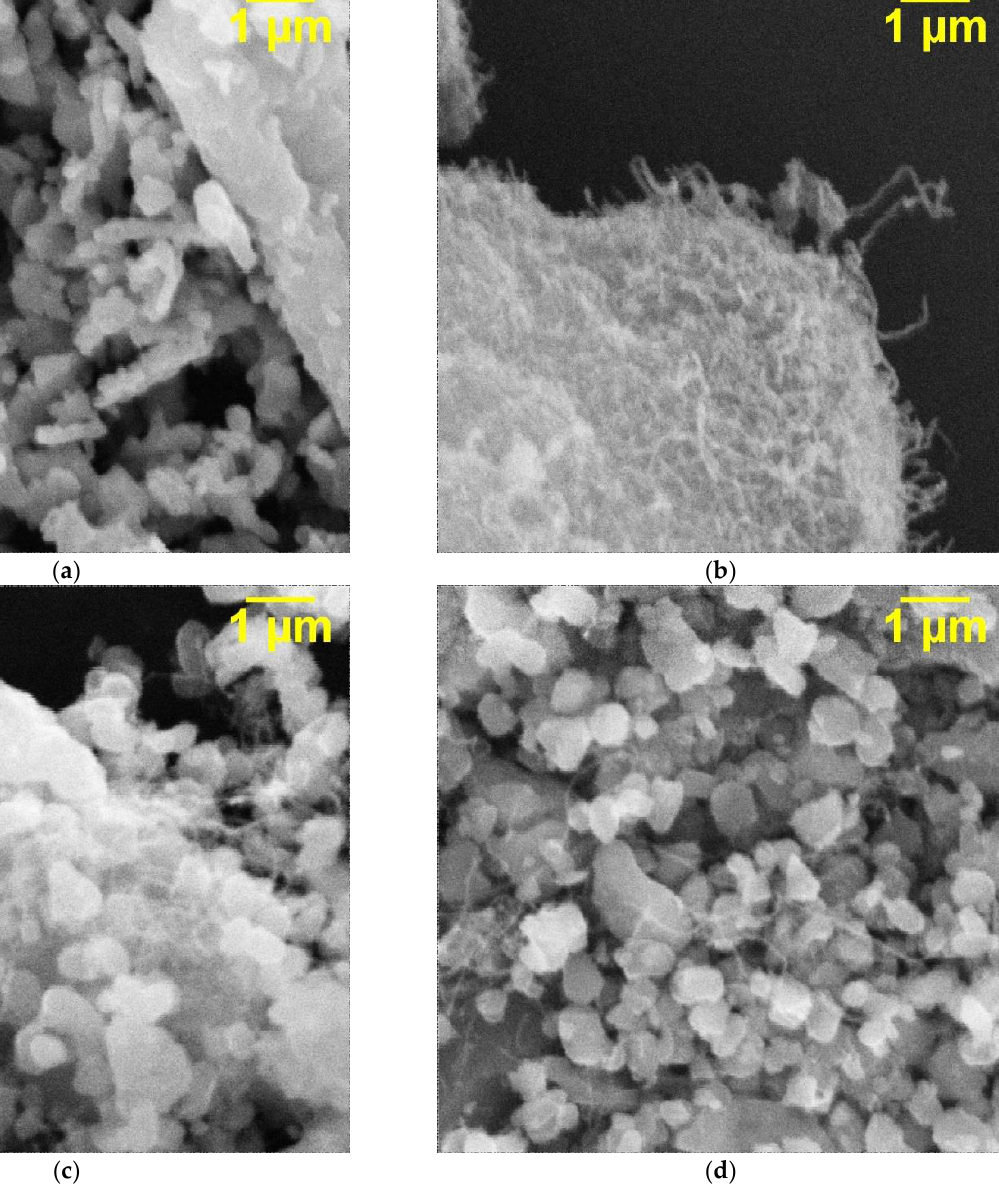
Figure 5. SEM microphotographs of ( a ) KFTO(H) powder, ( b ) MWCNTs, ( c , d ) composite KFTO(H)/MWCNTs (MWCNTs 1.5 wt.%).